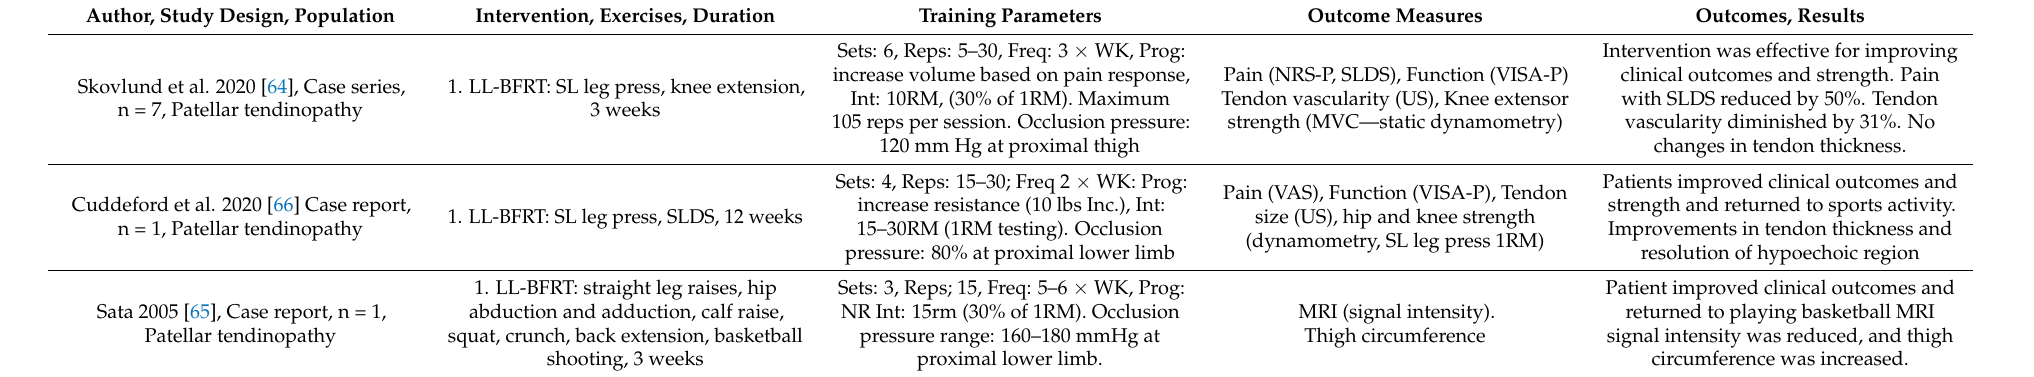
Table 4. Studies on BFRT in tendinopathy